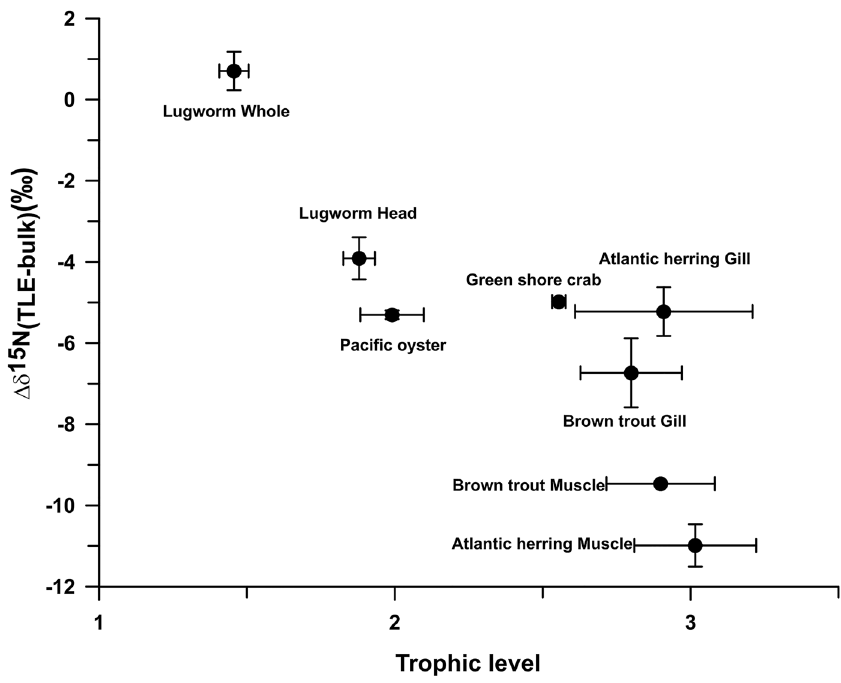
Fig 4. Difference in δ 15 N of lipid extracts (TLE) and bulk biomass ( Δδ 15 N TLE-bulk ) plotted against trophic levels. Δδ 15 N TLE-bulk data points represent averages of several individuals with the error bar reflecting the standard deviation of multiple individuals (S1 Table). Trophic level data points are plotted as averages (with error) of replicate analysis of amino acids of a single individual. Trophic levels were calculated according to Chikaraishi et al [29] using δ 15 N values of the amino acids phenylalanine and glutamic